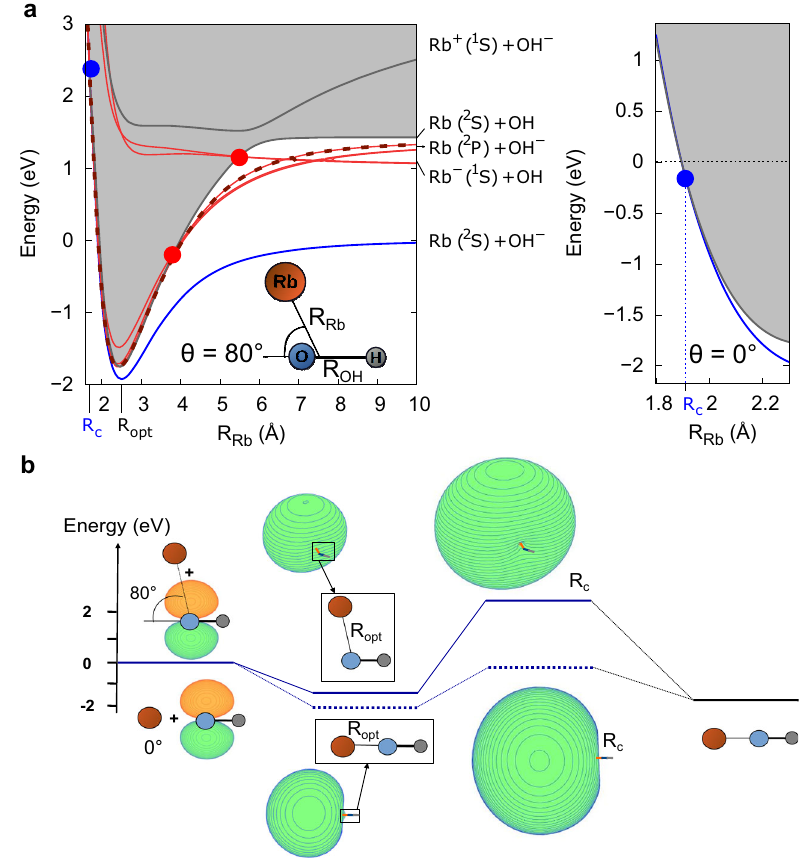
Fig. 1 Description of the Rb – OH − system. a Potential energy surfaces as a function of the distance R Rb between the Rb atom and the center of mass of O – H (left panel). The angle θ between the OH axis and the Rb atom is chosen to be 80 ∘ . The diabatic crossing between the excited state RbOH − complex (red curves) and its neutral counterpart RbOH (gray curve), is indicated by the two red dots. The crossing for the ground state RbOH − complex occurs at the inner part of the potentials (blue dot). R opt stands for the optimized R Rb distance (minimum of the interaction well) and R c corresponds to the distance at which the detachment occurs. The crossing in the repulsive region between the anionic and neutral PES for θ = 0 ∘ is shown in the right panel. b Reaction path for the AED reaction between ground state Rb and OH − shown for two different collisional angles: θ = 0 ∘ (dashed blue line) and θ = 80 ∘ (solid blue line). The zero corresponds to the energy of the Rb + OH − entrance channel. The orbital corresponding to the excess electron (highest occupied molecular orbital, HOMO) is shown.